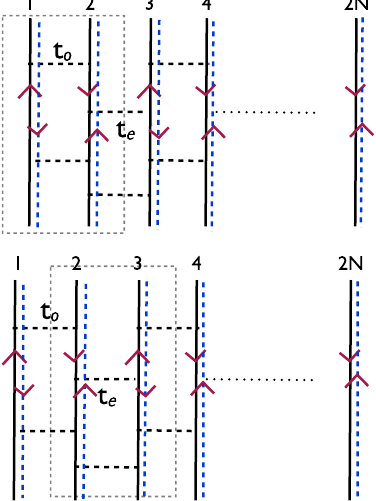
FIG. 3. Network model for the boson IQHE transition. Each edge channel now has a charged chiral mode and a counter- propagating neutral mode. The rest is the same as for fermions in Fig.